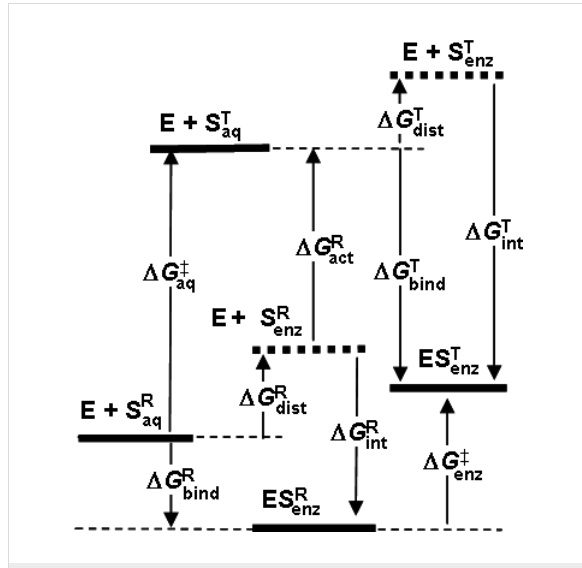
Figure 4: Free energy analysis of COMT catalysis.